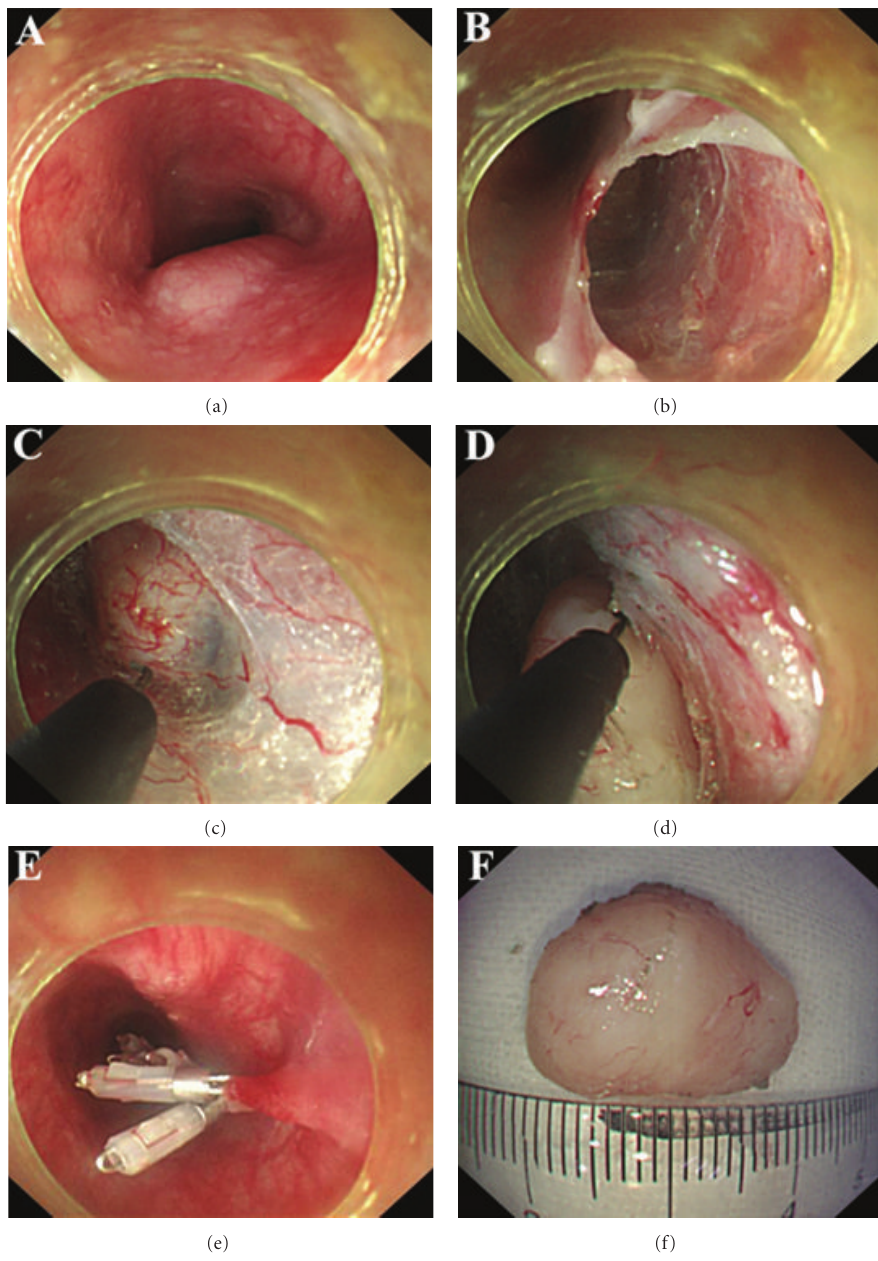
Figure 1: The endoscopic tunnelling submucosal resection procedure. (a) A submucosal tumor was found in esophagus (26cm from incisors). (b) After mucosal injection, a submucosal tunnel (about 5 cm long) was created by ESD technique. (c) The tumor was successfully exposed in the tunnel. (d) Tumor resection was being carried out in the tunnel. (e) The mucosal incision site was sealed by hemostatic clips. (f) The resected specimen was 1.5cm × 2.0